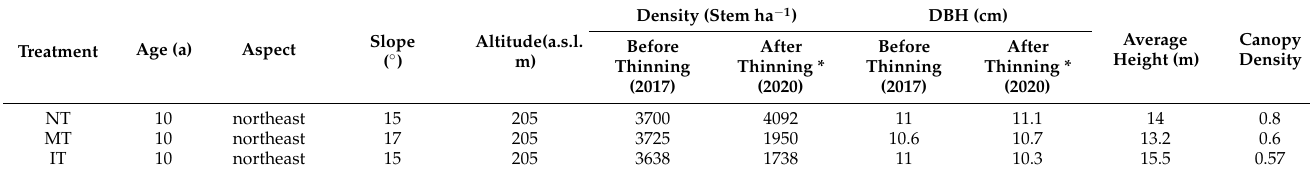
Table 1. Basic information of the stand before (2017) and after (2020) the